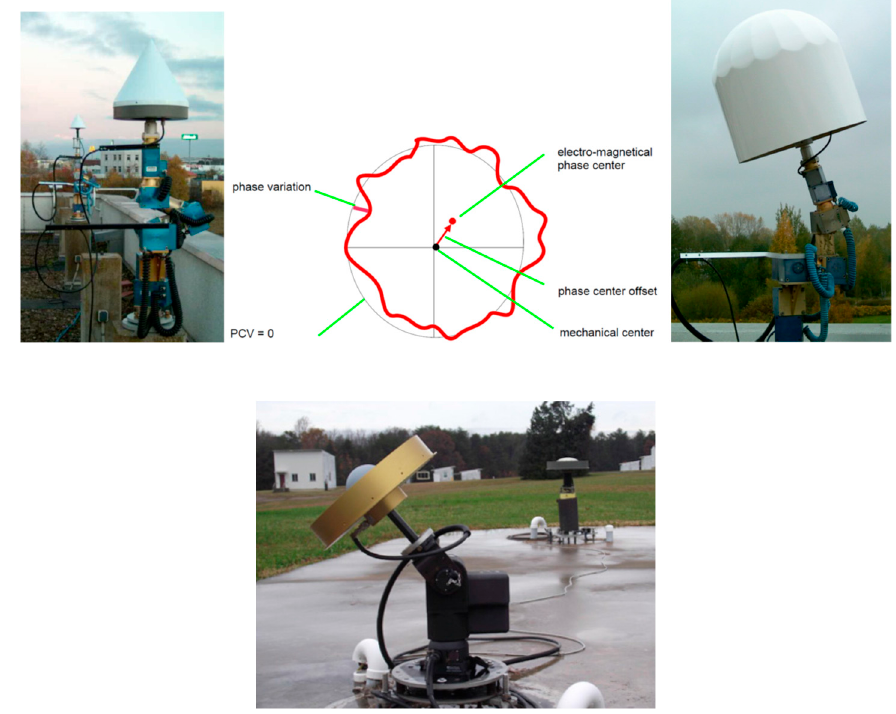
Figure 12. The absolute robot-based GNSS antenna calibration, as carried out in Garbsten, Germany. This procedure was applied to the Leica AR25.R3 antenna operating in Gavdos Cal/Val site. The lower image shows the NOAA’s National Geodetic Survey robotic system [33,34].